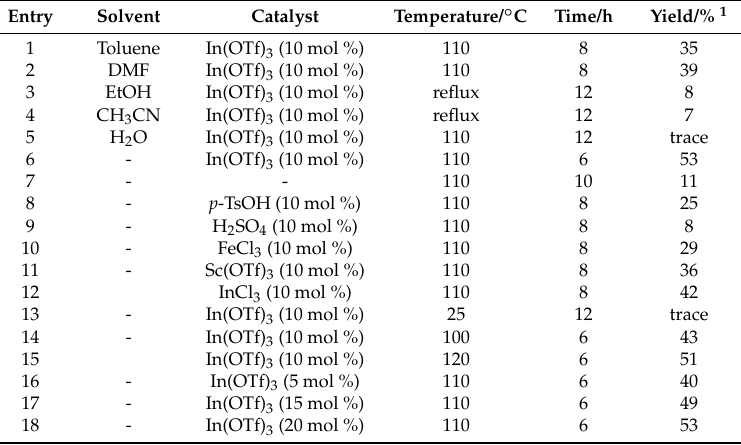
Table 1. Reaction conditions optimization for the synthesis 4a